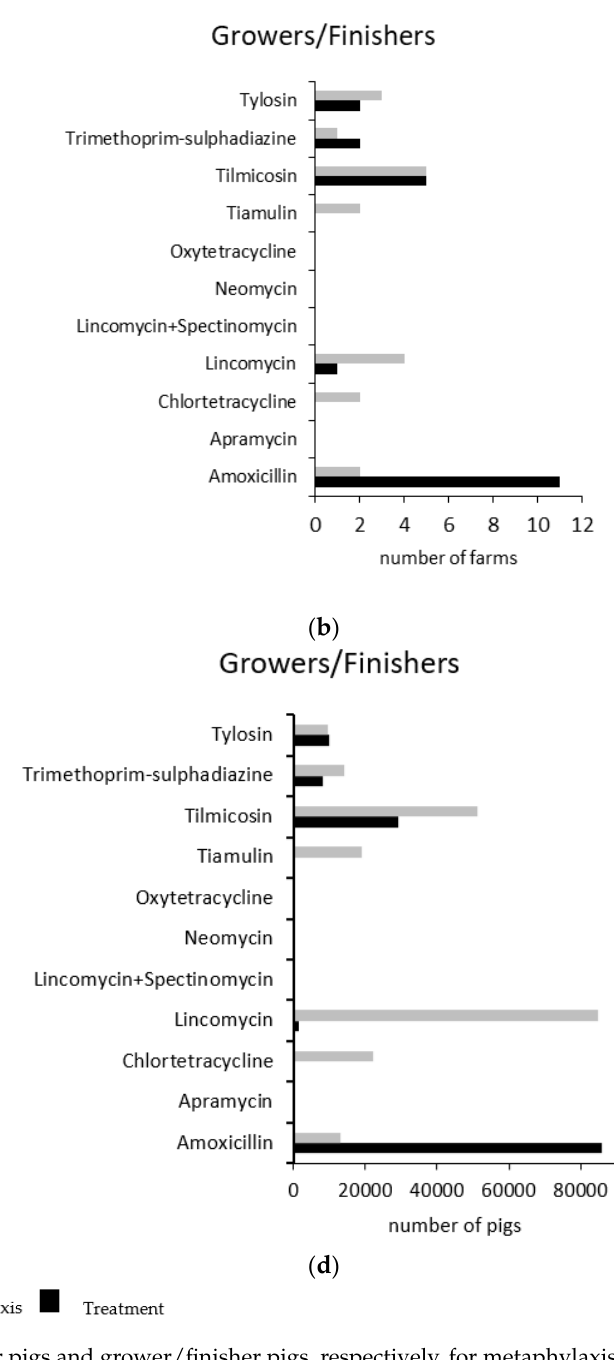
Figure 1. ( a , b ) Antibiotics administered in-water to weaner pigs and grower/finisher pigs, respectively, for metaphylaxis and treatment by number of farms. ( c , d ) Antibiotics administered in-water to weaner pigs and grower/finisher pigs respectively for metaphylaxis and treatment by number of pigs currently housed on study farms. (25 single-site and multi-site pig farming enterprises, 459,167 growing pigs).